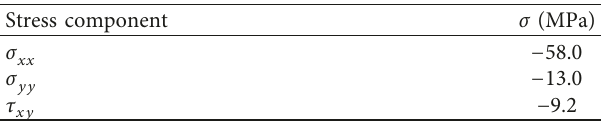
Table 2: Experimental values (average value and range) of the mechanical properties of the intact Lac du Bonnet granite [44].